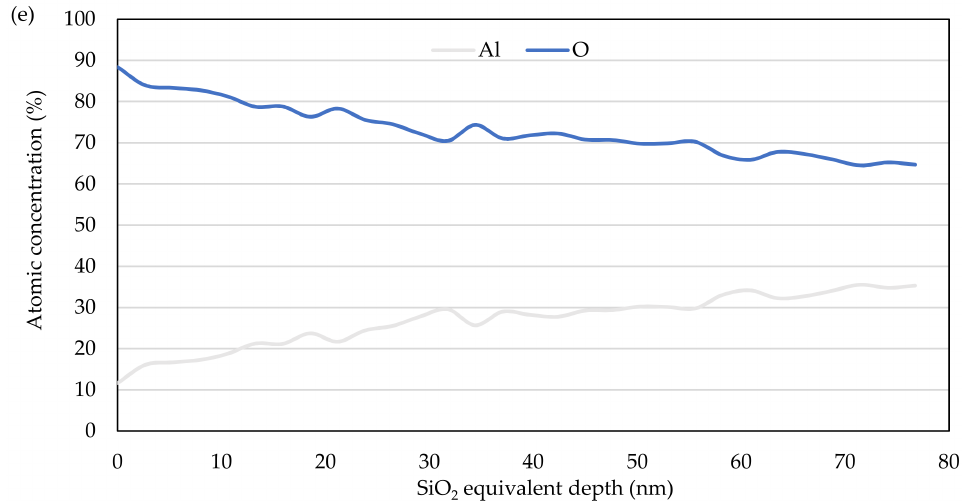
Figure 7. Depth profile analysis of AA1050 ( a ) at RT, ( b ) annealed at 100 ◦ C, ( c ) annealed at 200 ◦ C, ( d ) annealed at 300 ◦ C, and ( e ) annealed at 400 ◦ C.